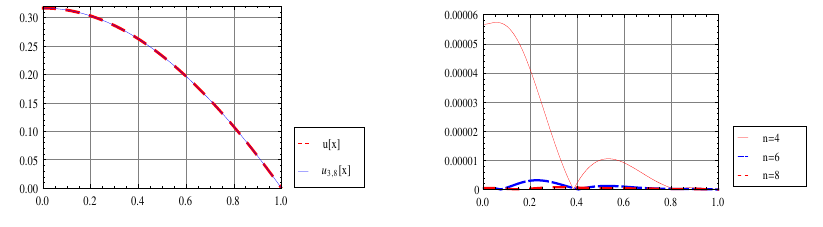
Figure 1. Comparison of exact solution u ( x ) and approximate solution u 3 , 8 ( x ) (left side) and E (right side) for Example 1( k =